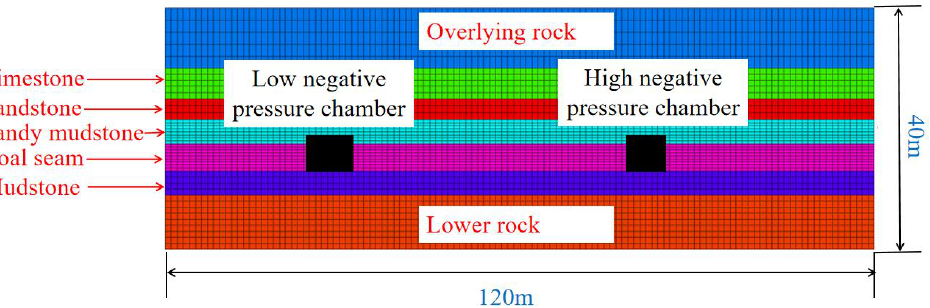
Figure 3. Numerical model diagram. Table 2. Physical and mechanical properties of each stratum.